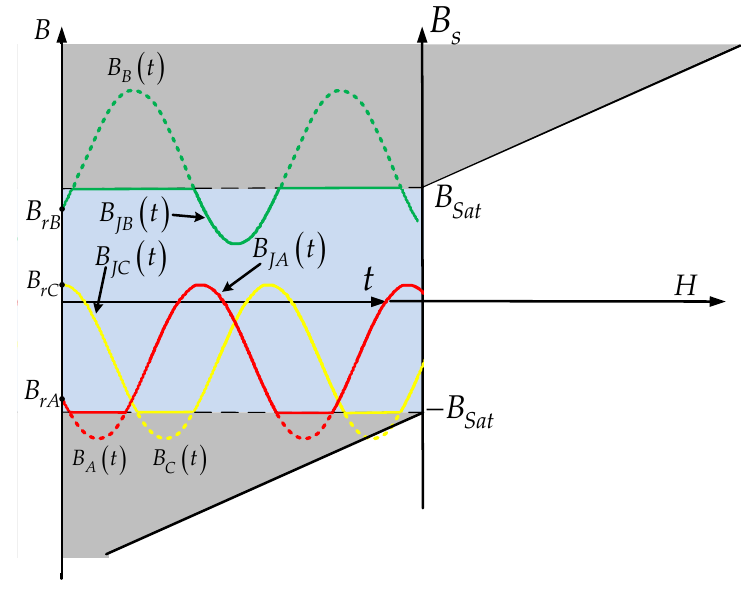
Figure 3. Three-phase magnetic density schematic diagram.